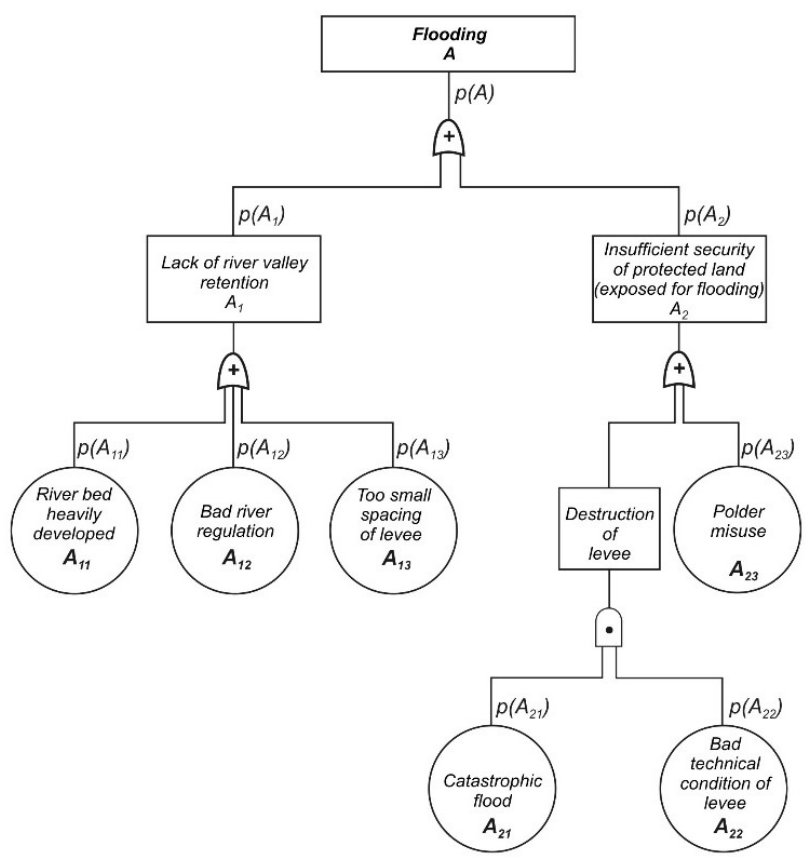
Figure 3. Fault tree for the structure of the hydrological system of the Sola River catchment up to the Zywiec post.